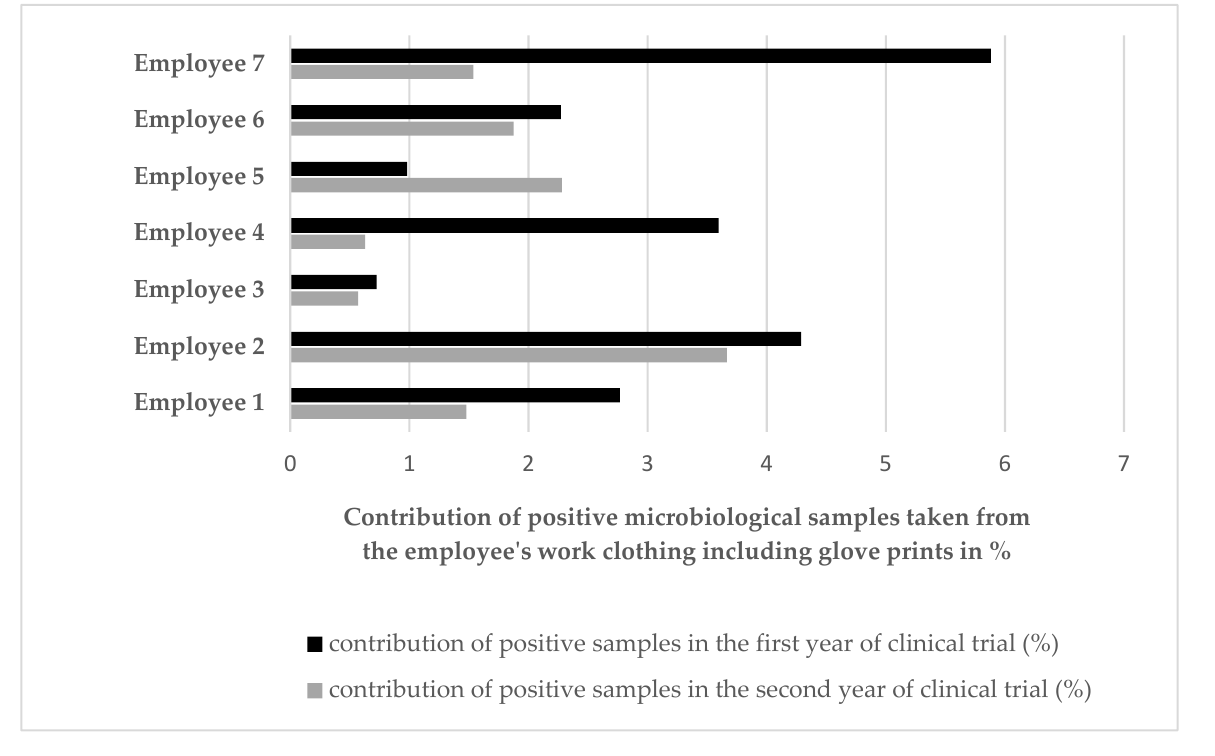
Figure 5. Microbial contamination observed in the samples taken from the staff (including glove prints). The diagram shows the total score for each individual employee by year over the course of the entire trial.